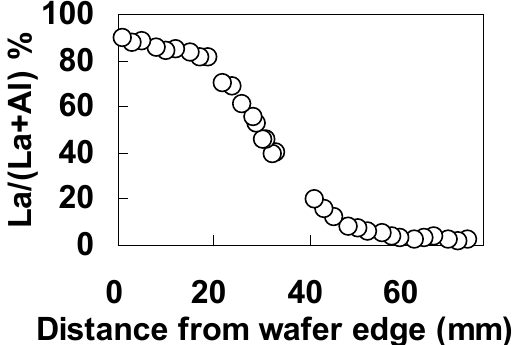
/Si gate stacks 2